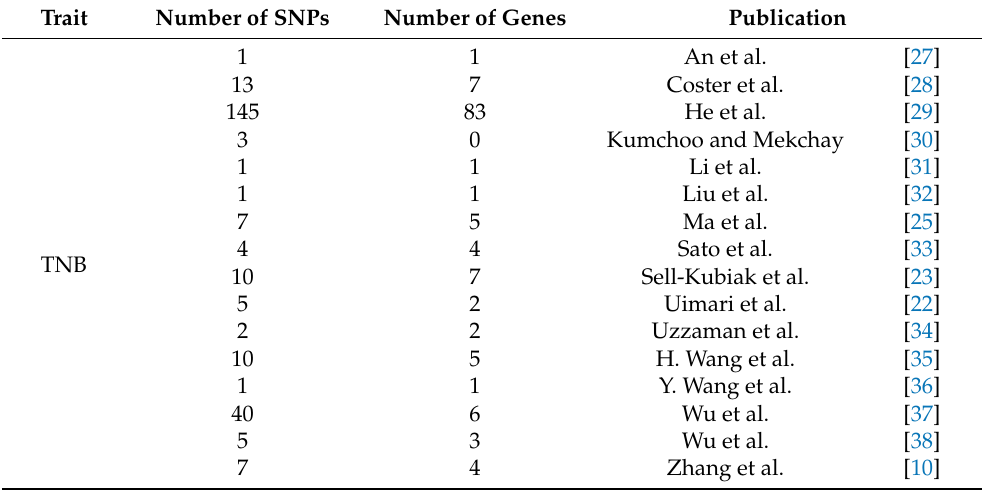
Table 2. Publications reporting SNPs and genes associated with a total number of piglets born